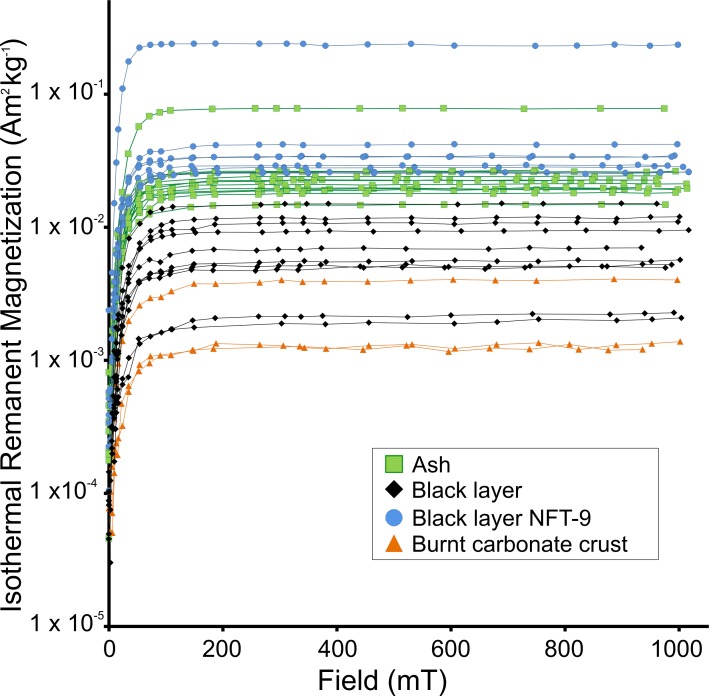
Progressive IRM acquisition curves per facies on logarithmic scale.Green squares = ash; black diamonds = black layer; blue circles = black layer from the intensively trampled NFT-9; orange triangles = burnt carbonate crust). Axis Y is on logarithmic scale.